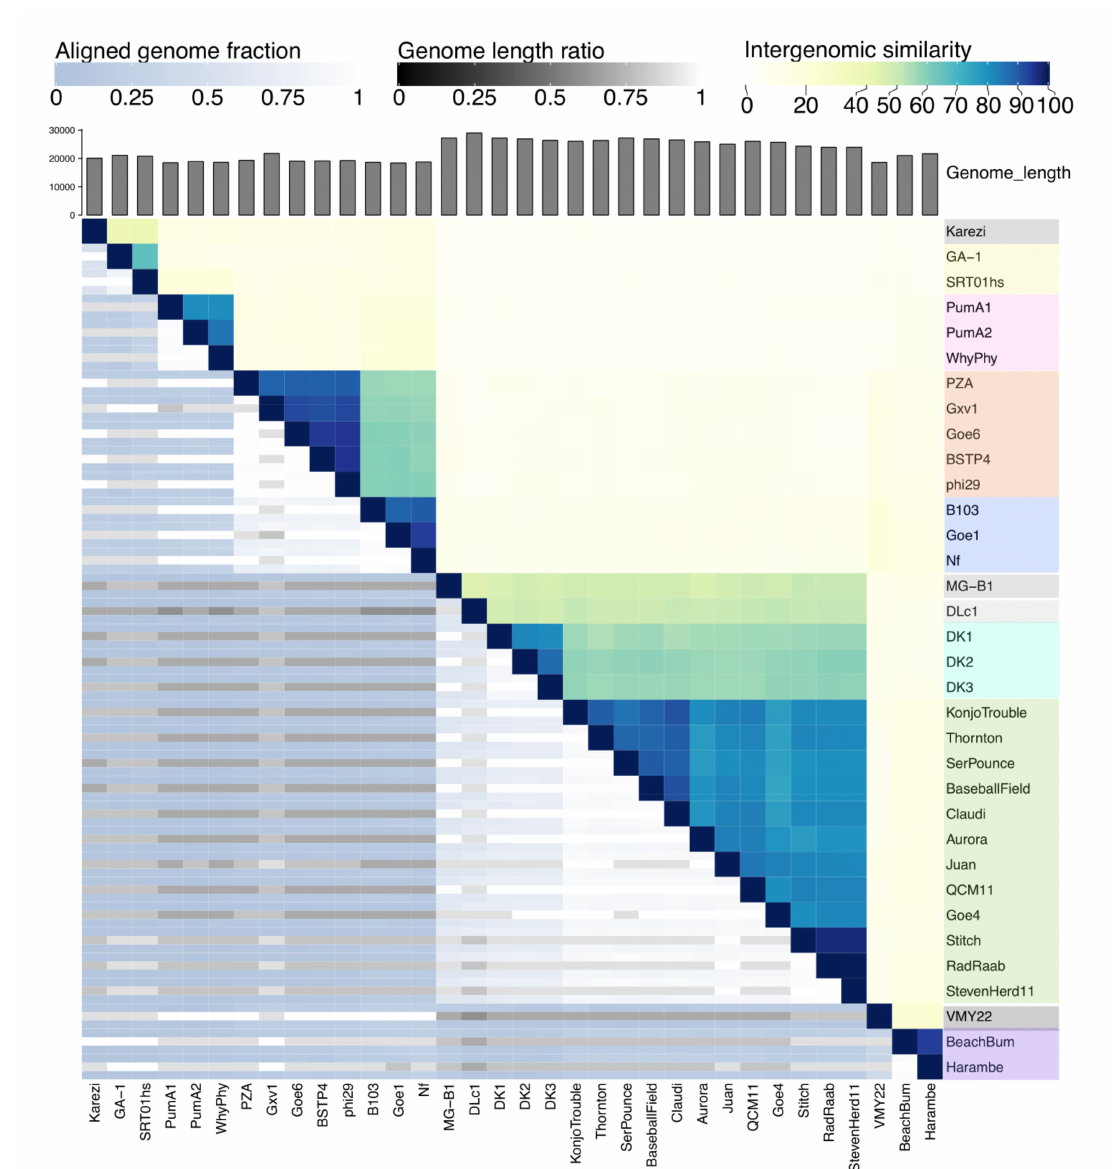
Figure 3. VIRIDIC heatmap of the 34 phi29-like phages. Intergenomic similarities of the phages are shown on the right side with the colored scale where more defined clusters are seen compared to the dot plot. The similarities scores are found in Table S2. The aligned genome fraction and genome length ratio values are shown on the left side with their corresponding scales. Overlayed is the color coding of the seven major clusters, where grey indicates singleton